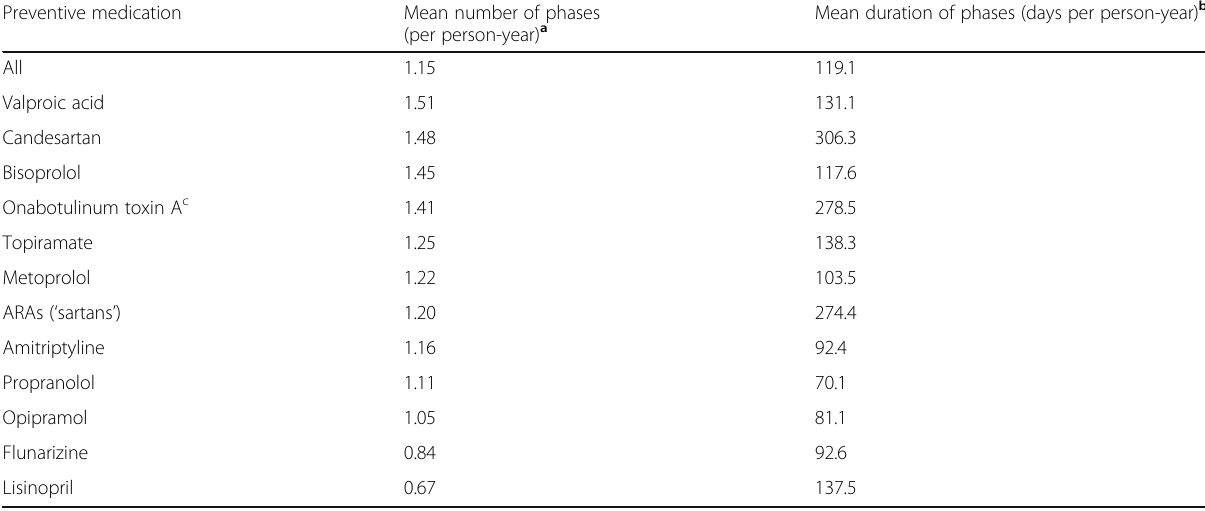
Table 4 Phases of prescribed preventive medications for patients with migraine who received at least one prescription for the respective in- and off-label (Group 2) preventive medication in the German Company Sickness Fund Database 2008 to 2016